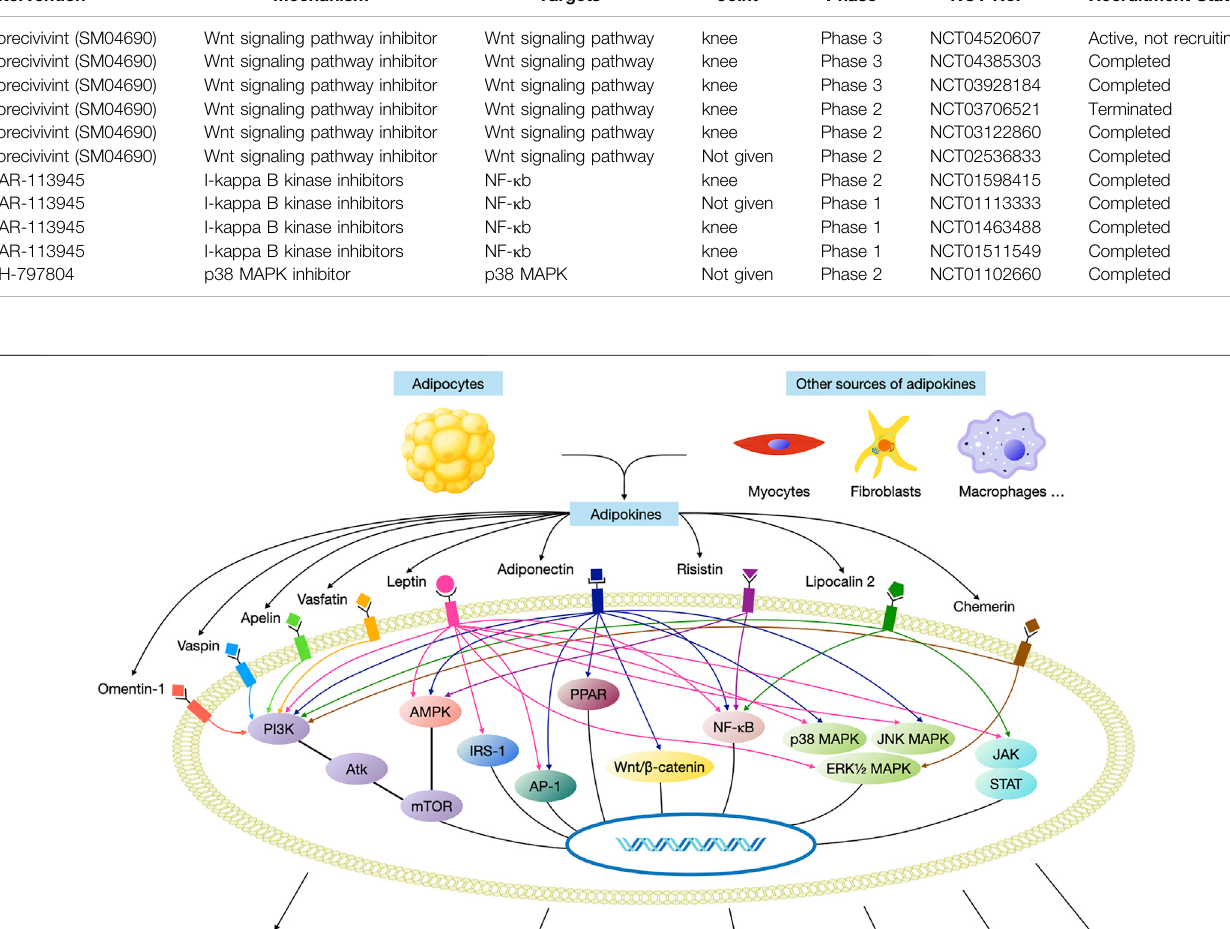
TABLE 1 | Ongoing clinical trials investigating inhibitors of signaling pathways as treatment for OA. Intervention Mechanism